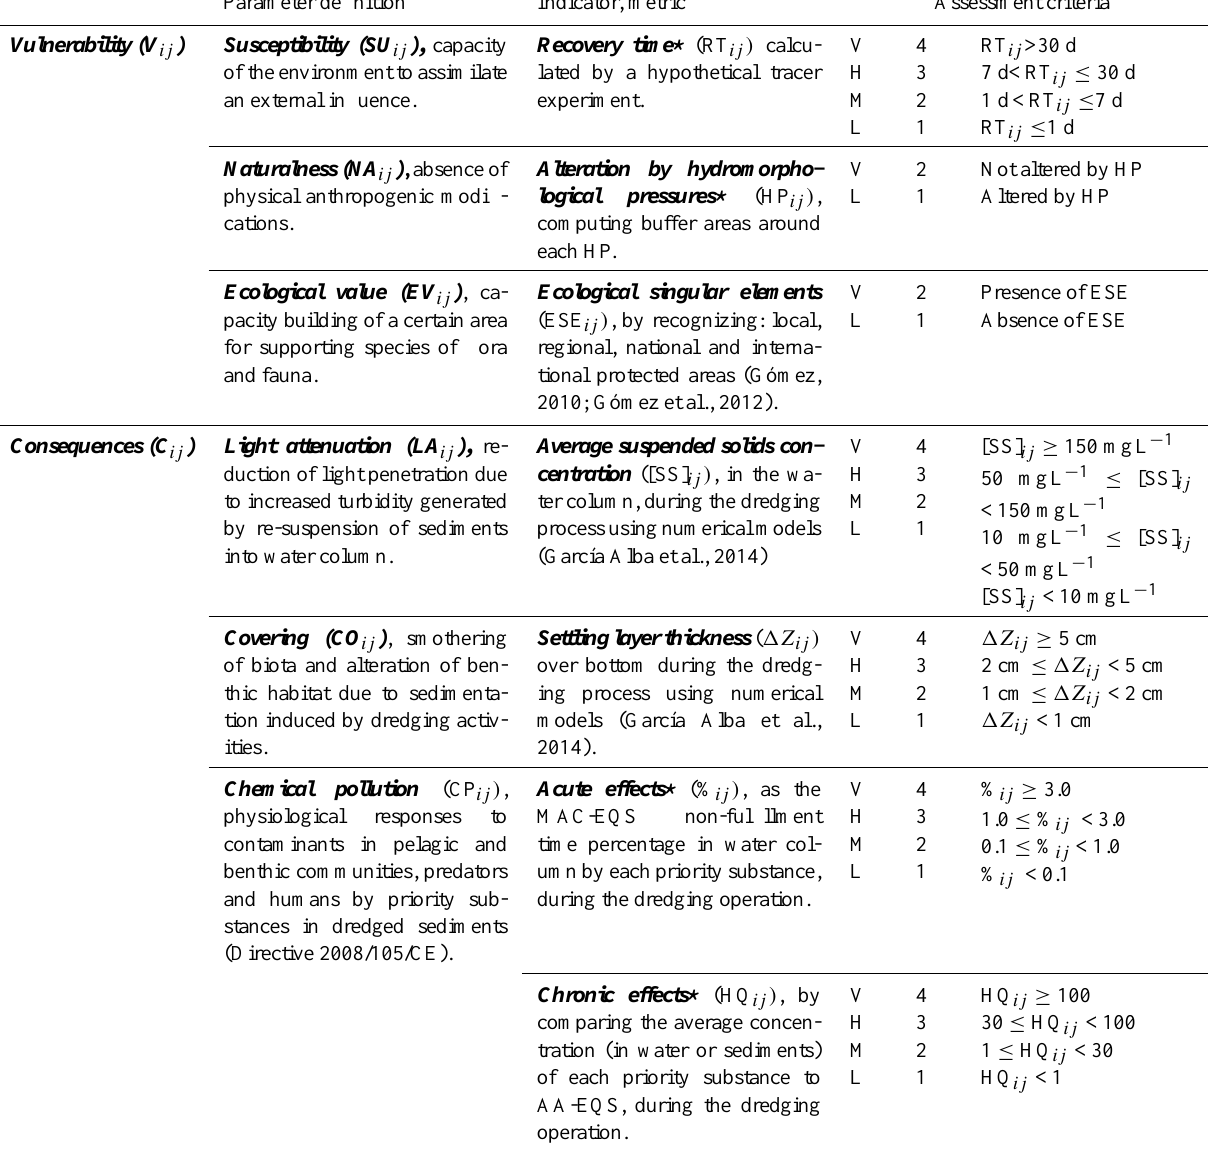
Table 1. Definition, indicator, metric and assessment criteria to estimate each parameter in the environmental risk